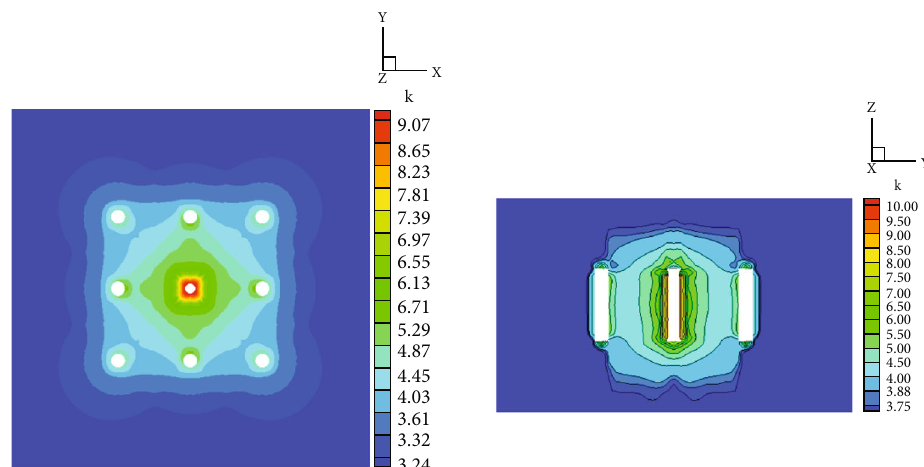
Figure 9: Permeability changes in the horizontal and vertical pro fi les after hydraulic fracturing.